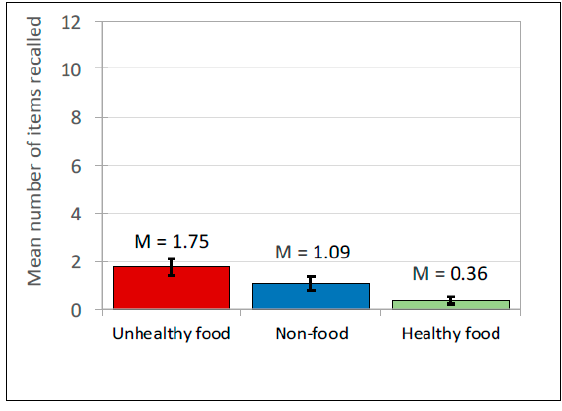
Figure 6. Free brand recall: Mean scores. Table 6. Recall and recognition: Results of pairwise